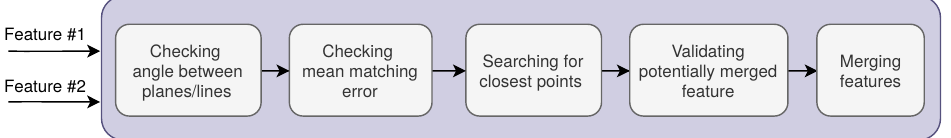
Figure 8. Steps performed to merge two features, based on angle, matching error, and distance between